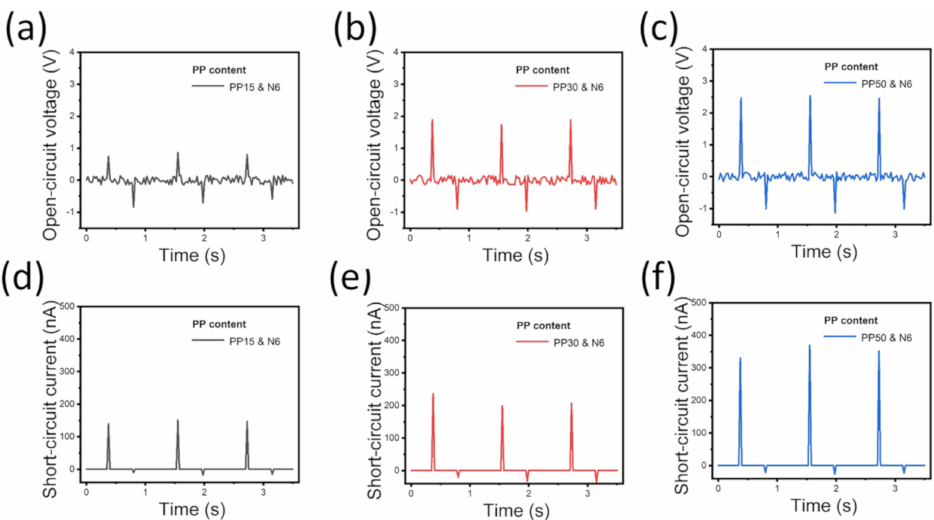
Figure 4. E ff ect of PP basis weight on the electrical output performance of the NMF-TENGs. Output voltage of NMF-TENG with ( a ) PP15, ( b ) PP30, and ( c ) PP50. Output current of NMF-TENG with ( d ) PP15, ( e ) PP30, and ( f )